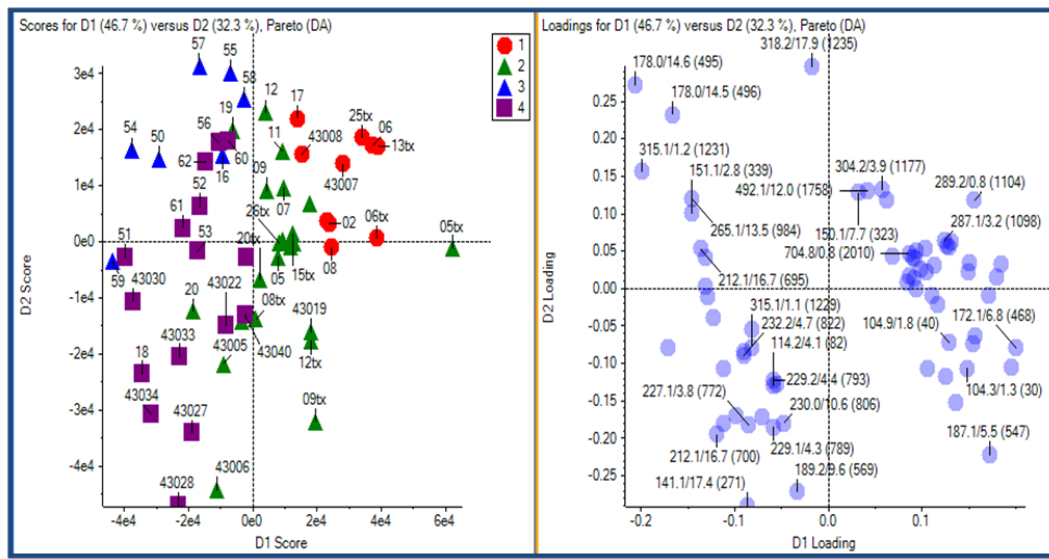
Figure 7. PCA-DA plot of the ccRCC HILIC-LC–ESI–MS after manual feature selection. Groups were color-coded as: 1-red: female ccRCC, 2-green: male ccRCC, 3- blue: female control, 4-purple: male control. 55 samples, 68